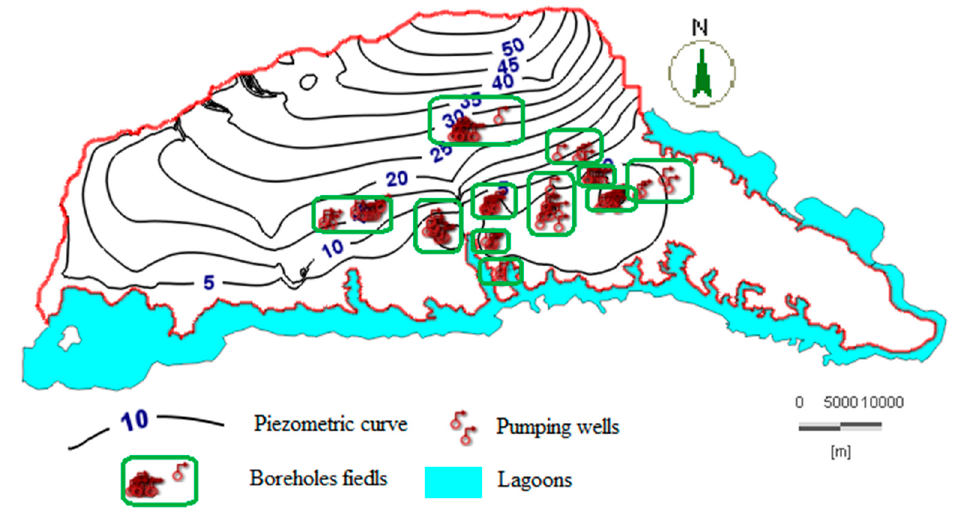
Figure 7. Diagram of the computed and observed hydraulic heads based on the simulation: ( A ) calibration and ( B ) validation. E (m): Average of the absolute deviations, RMS (m): Root Mean Square error, σ (m): error standard deviation.